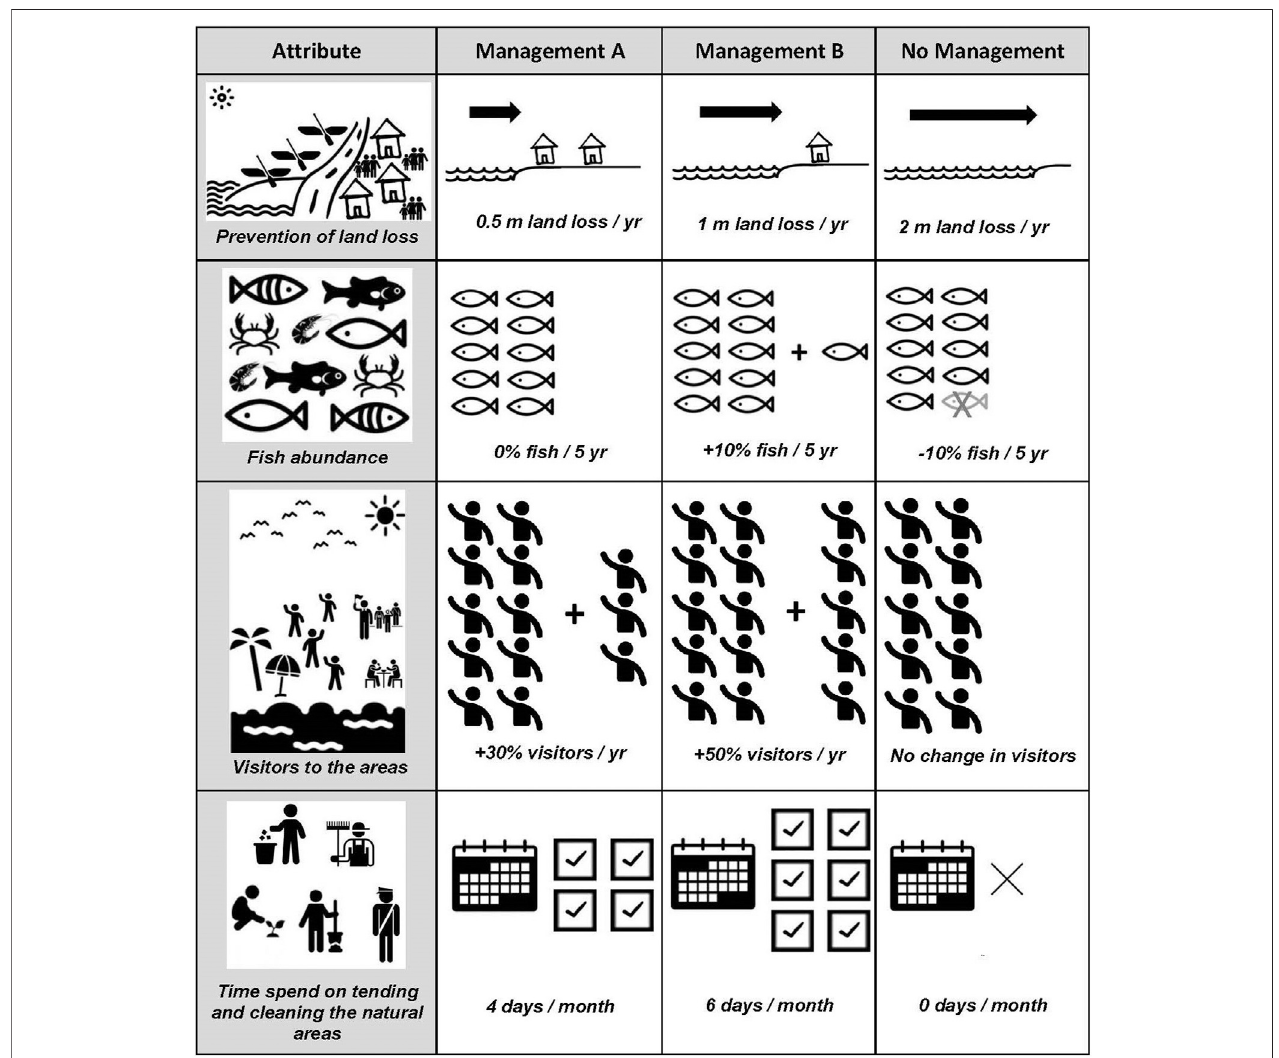
FIGURE 2 | Example choice card for the time payment vehicle, used in both the rural and urban study site.